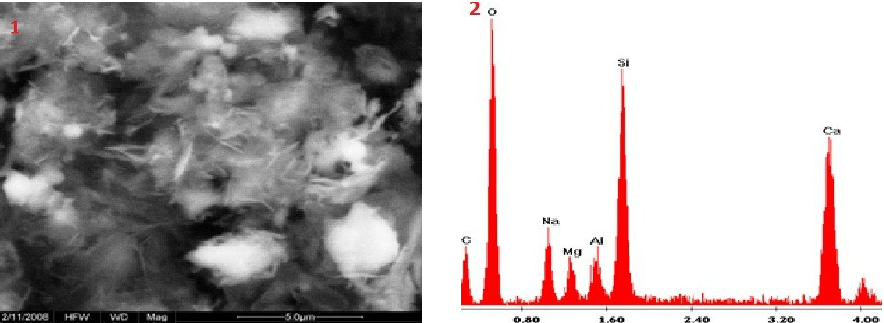
Figure 10. SEM (1) and EDX (2) of reaction product ZB2 (synthesized with 1M NaOH).